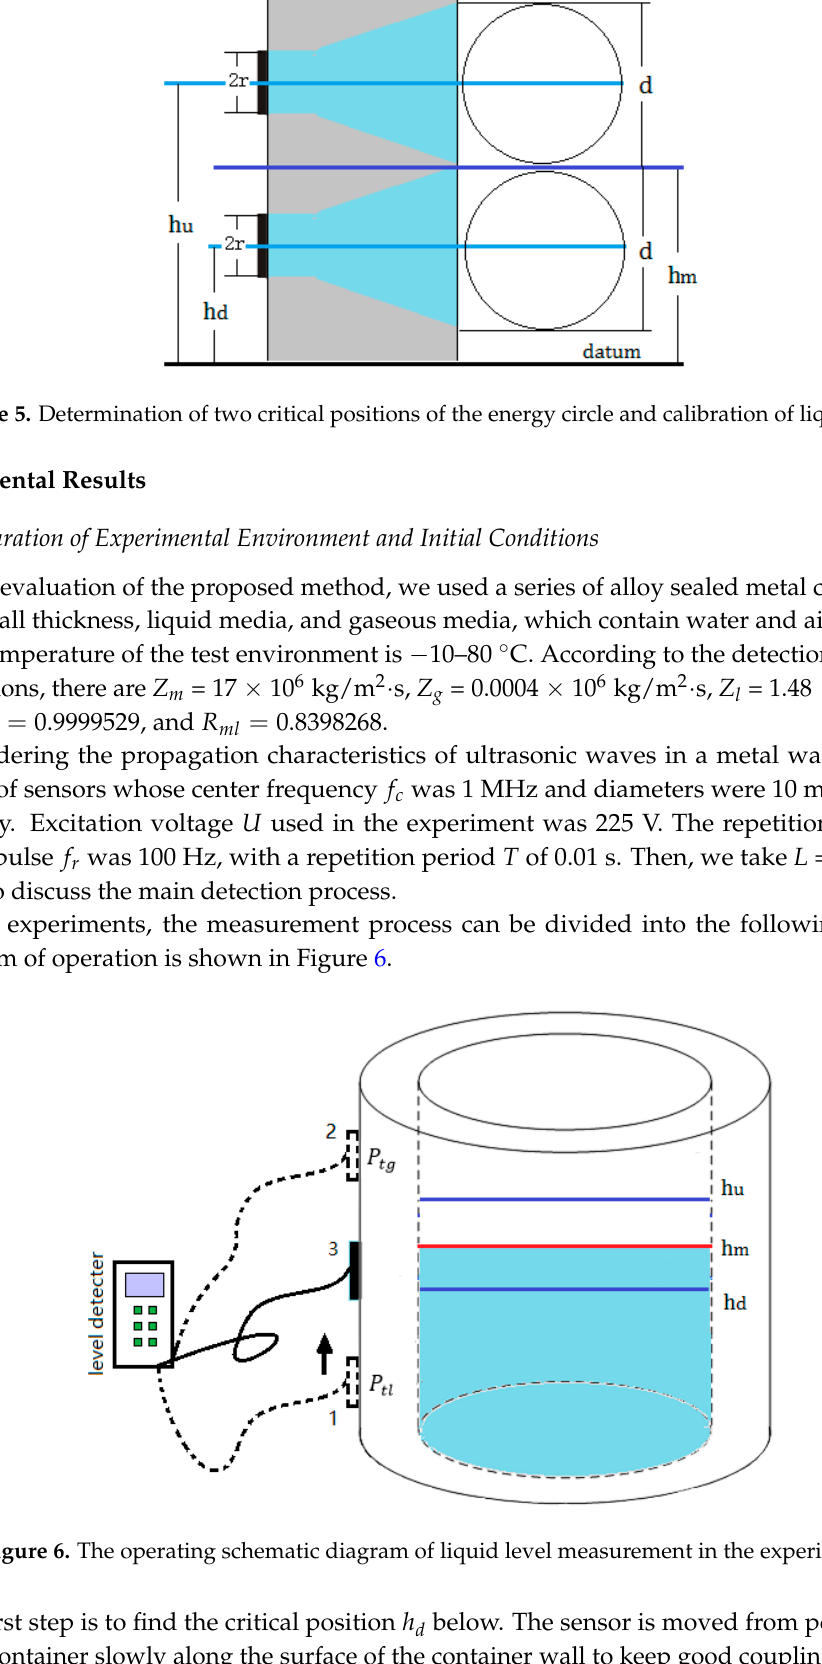
Figure 4. The relationship between the total energy P (cid:2930) and ∆h .